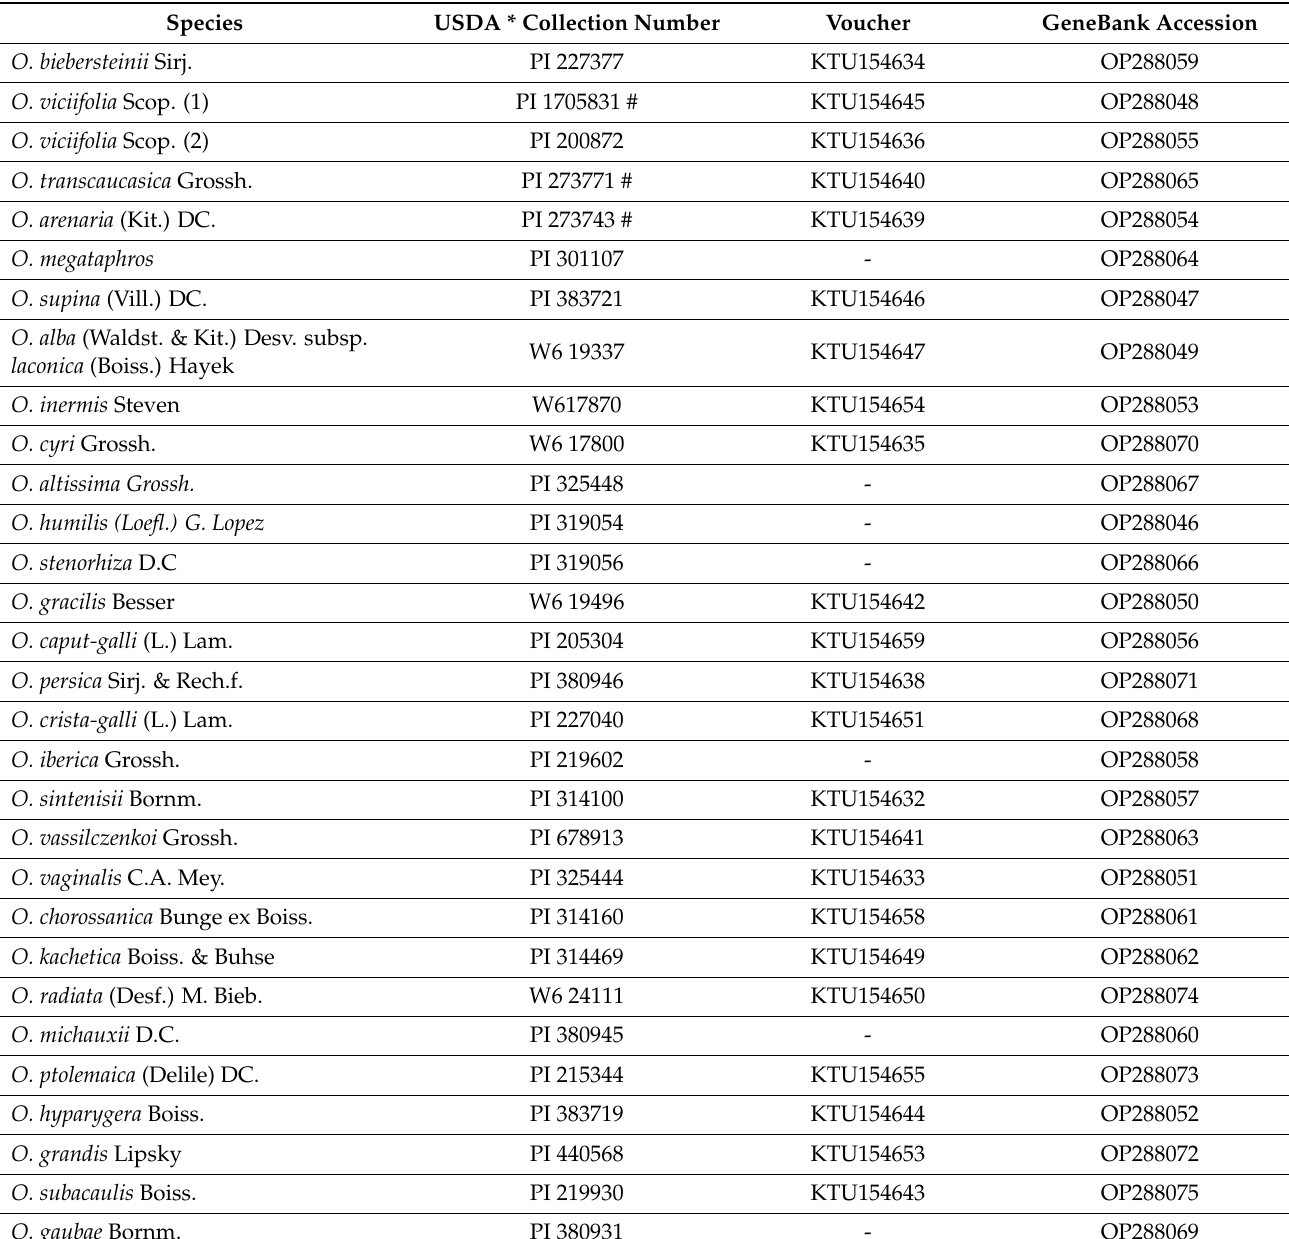
Table 2. General characteristics of the analysed taxa and the GenBank accession numbers of the sequences obtained in this